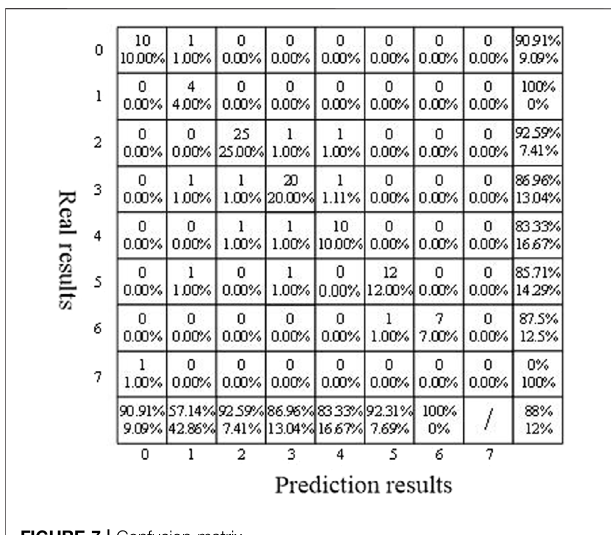
FIGURE 7 | Confusion matrix.